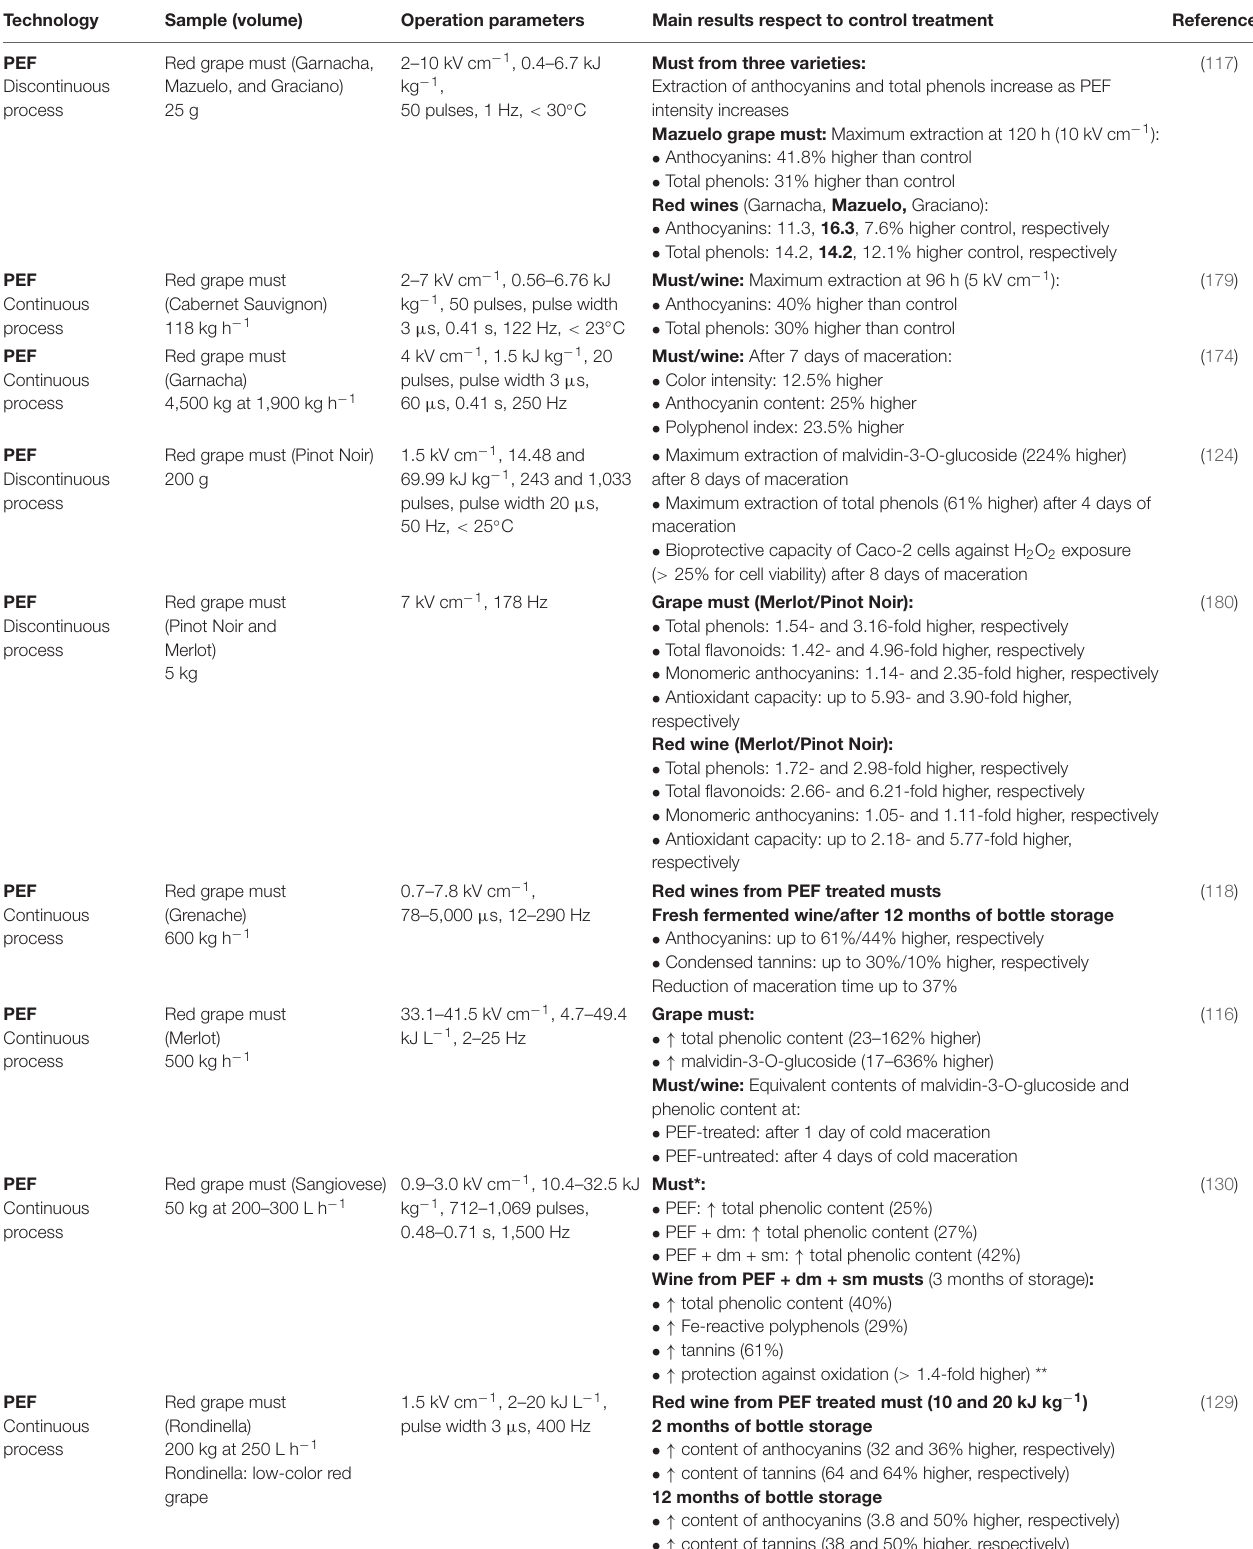
TABLE 3 | Applications of pulsed electric fields to improve the extraction of phenolic compounds during red winemaking.